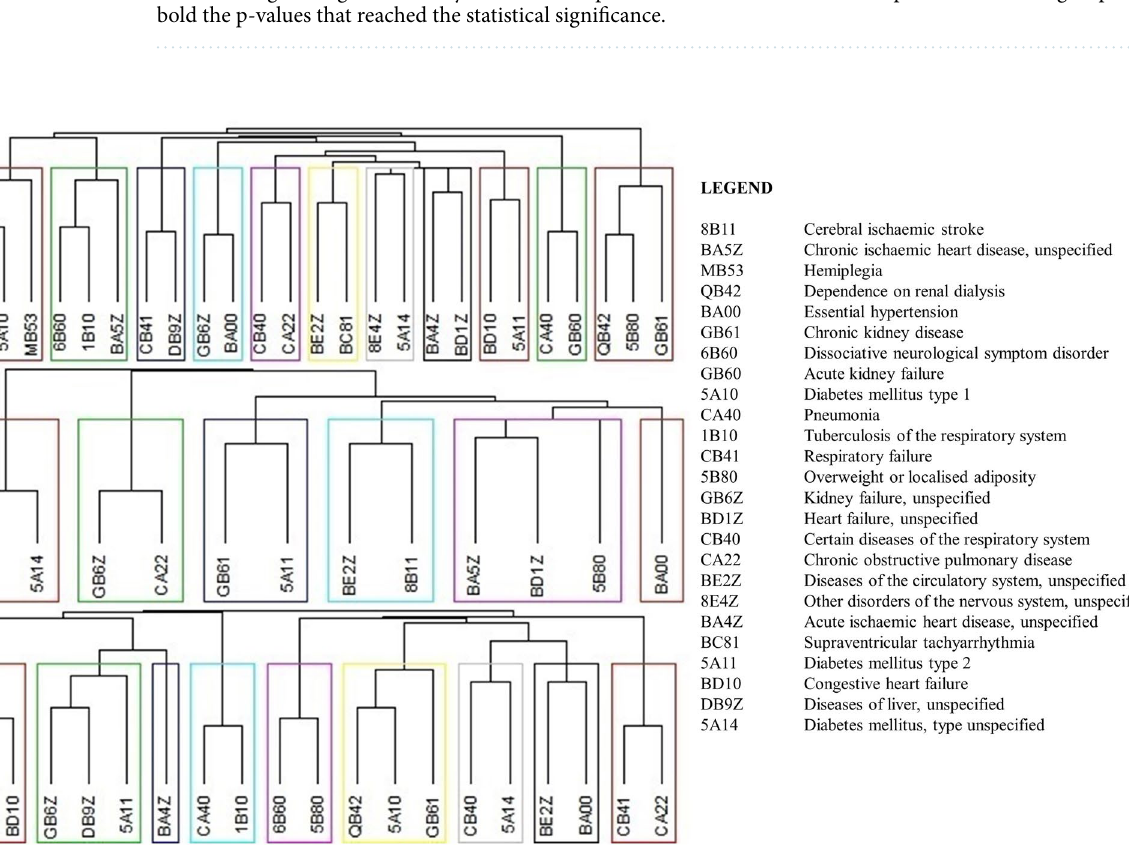
Figure 2. Co-occurrence clusters for All Subjects ( A ), Women ( B ) and Men ( C